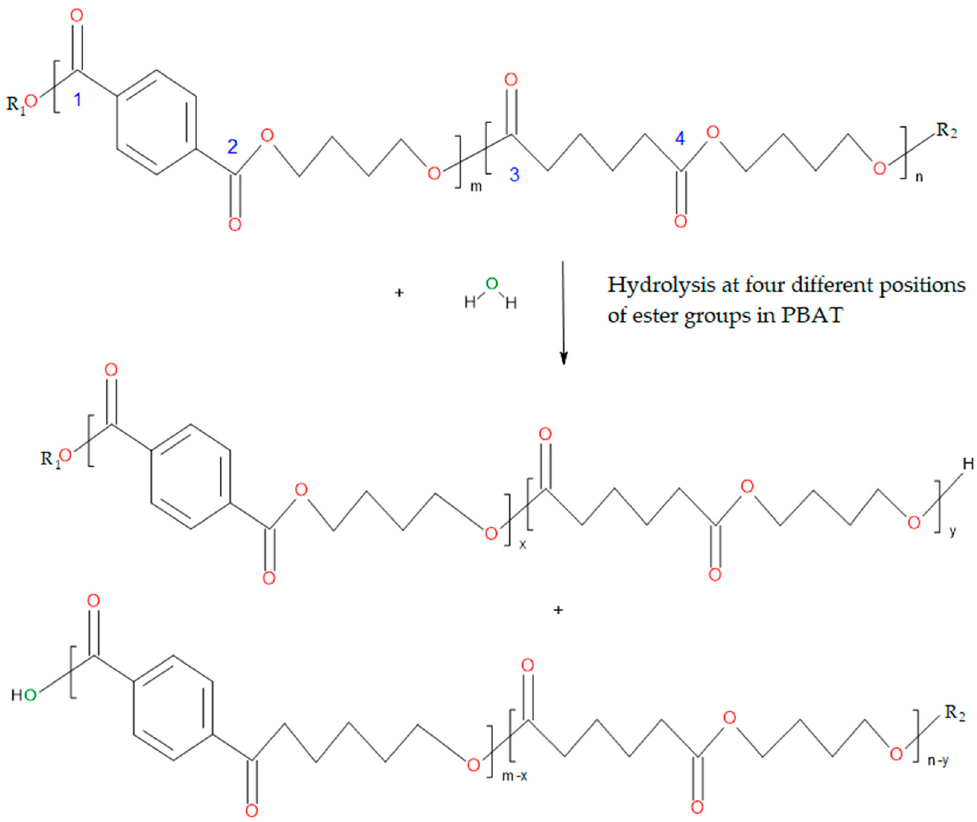
Figure 3. Proposed mechanism of the PBAT hydrolysis with four different reaction positions.